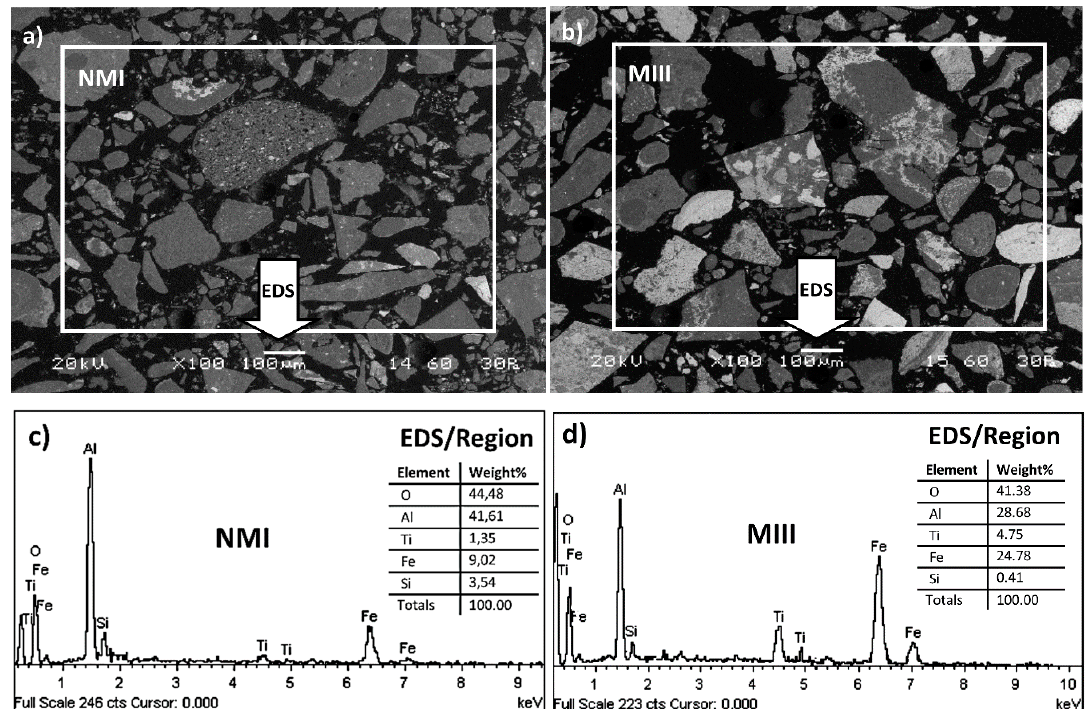
Figure 18. Cross-sectional SEM-BSE images of polished surfaces of ( a ) non-magnetic product NMI and ( b ) magnetic product MIII obtained after magnetic separation of the − 0.300 mm fraction. EDS spectra obtained in regions (marked by white rectangle) of ( c ) non-magnetic product NMI and ( d ) magnetic product MIII confirm the metal content (Fe and Ti) increase in the MIII sample and the subsequent decrease of Al content.